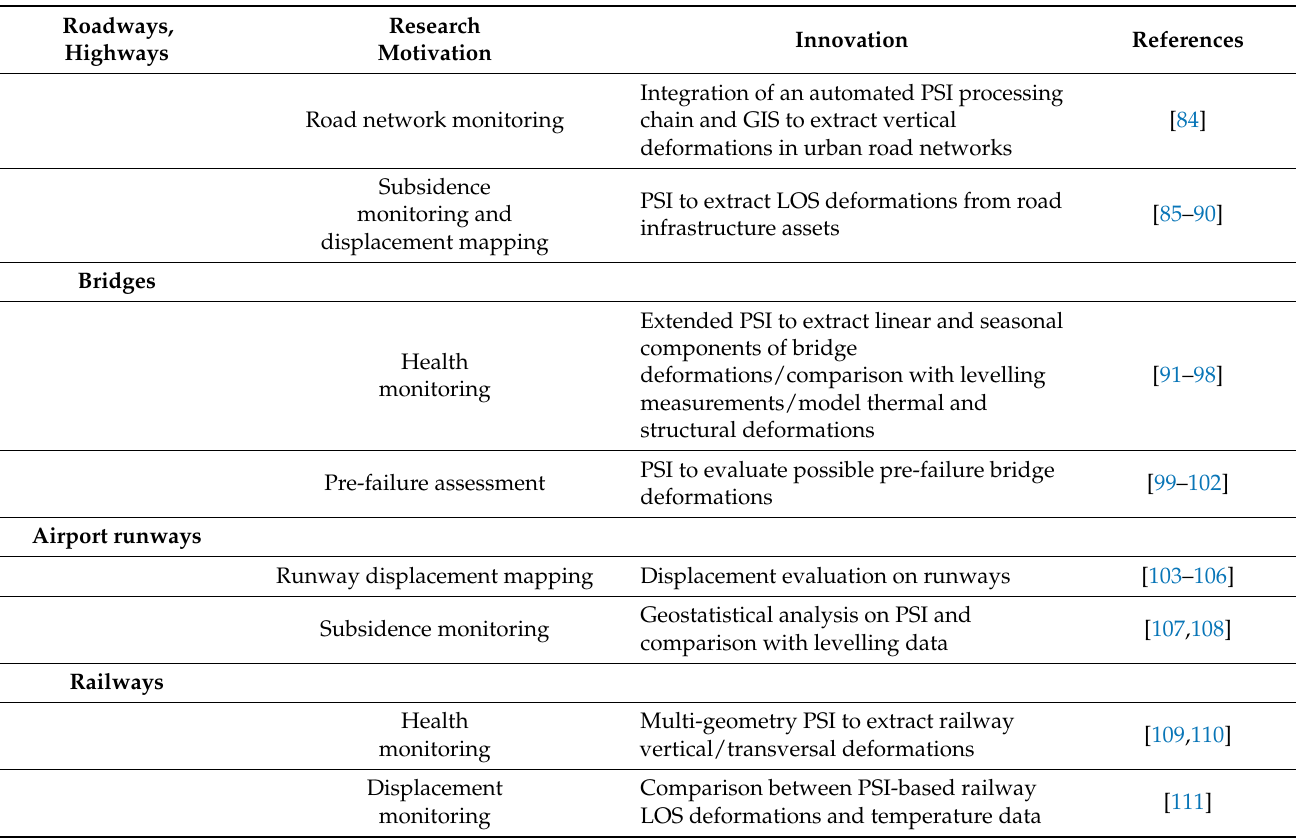
Table 2. PSI Applications: Stand-alone use of satellite technology for transport infrastructure monitoring.